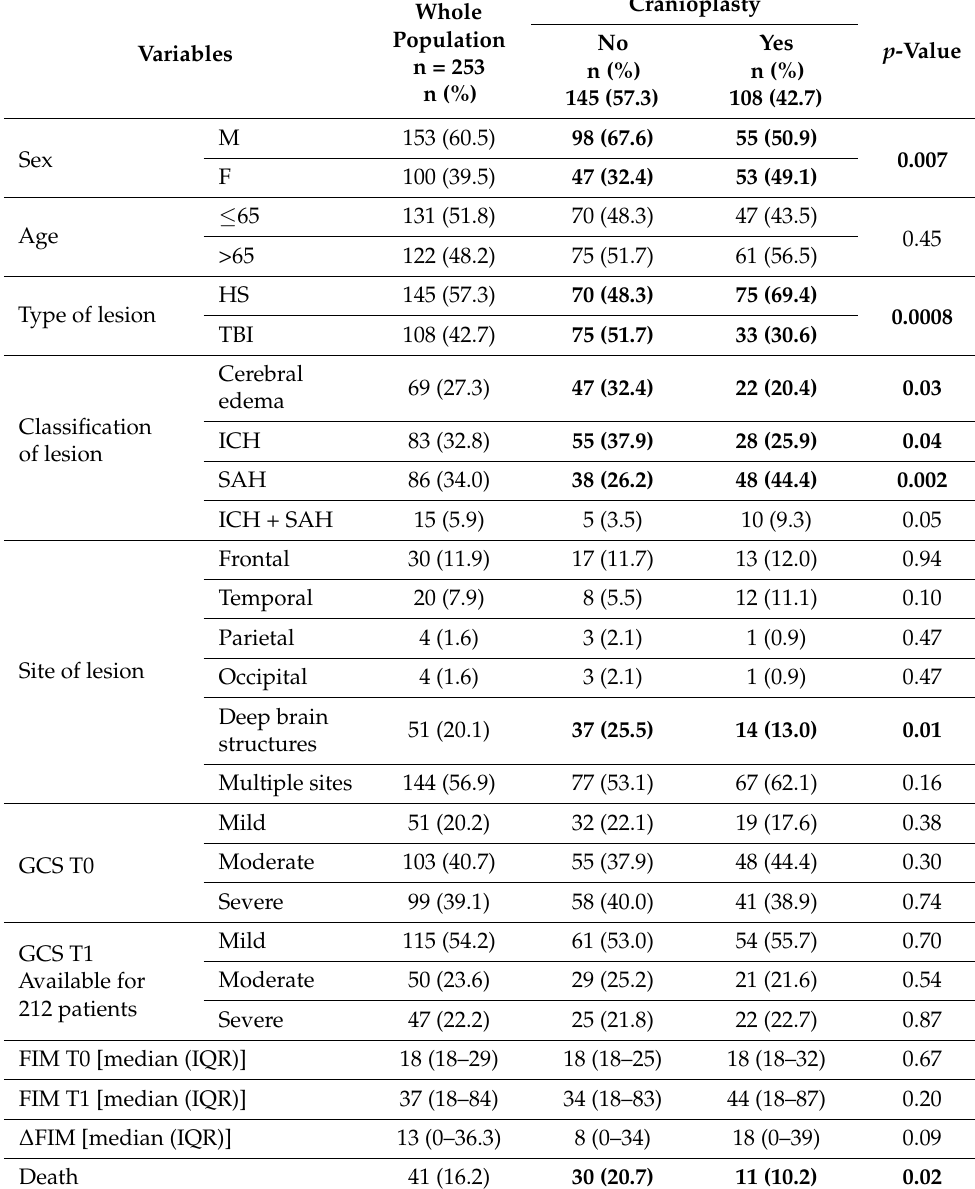
Table 1. Clinical and rehabilitation characteristics of the population as a whole and subdivided into two groups based on whether or not the cranioplasty surgery was